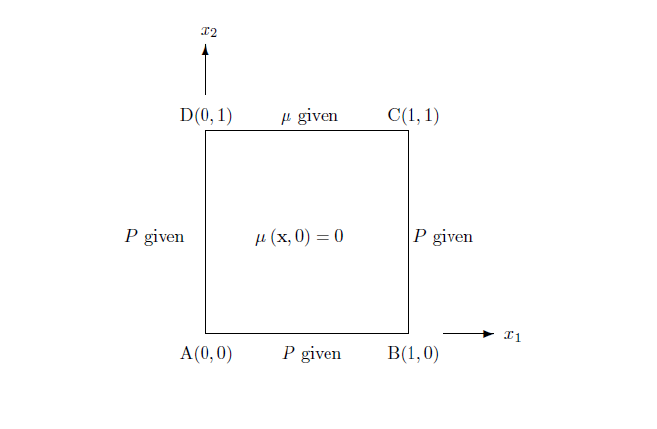
Figure 1. The boundary conditions for the problems in Section